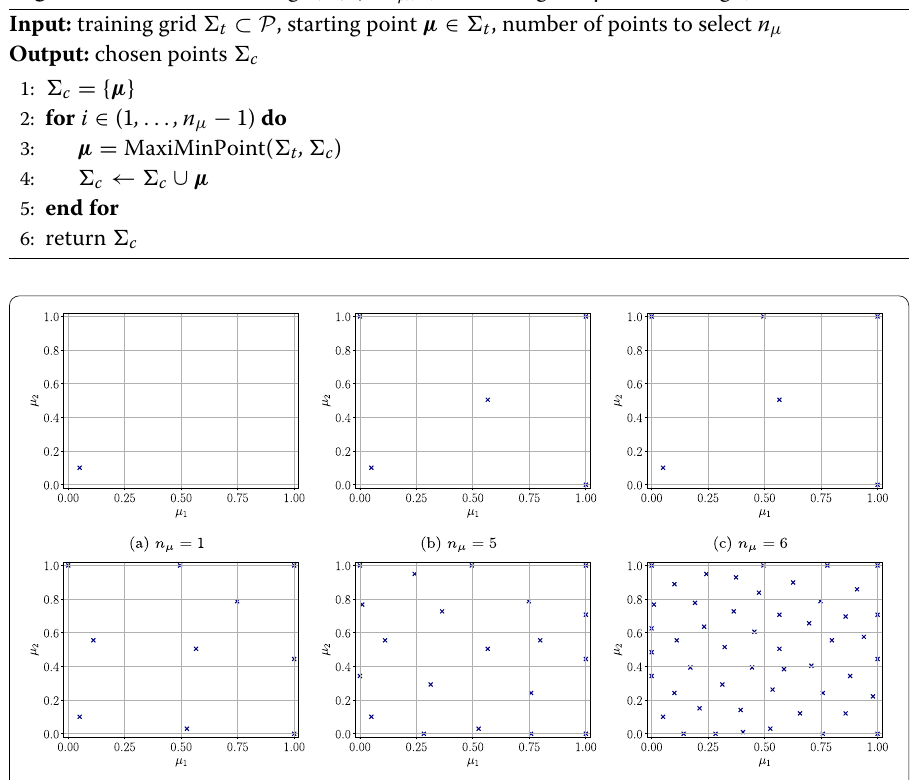
Algorithm 2 MaxiMinDesign( (cid:12) t , μ , n μ ) (construct greedy MMD design)